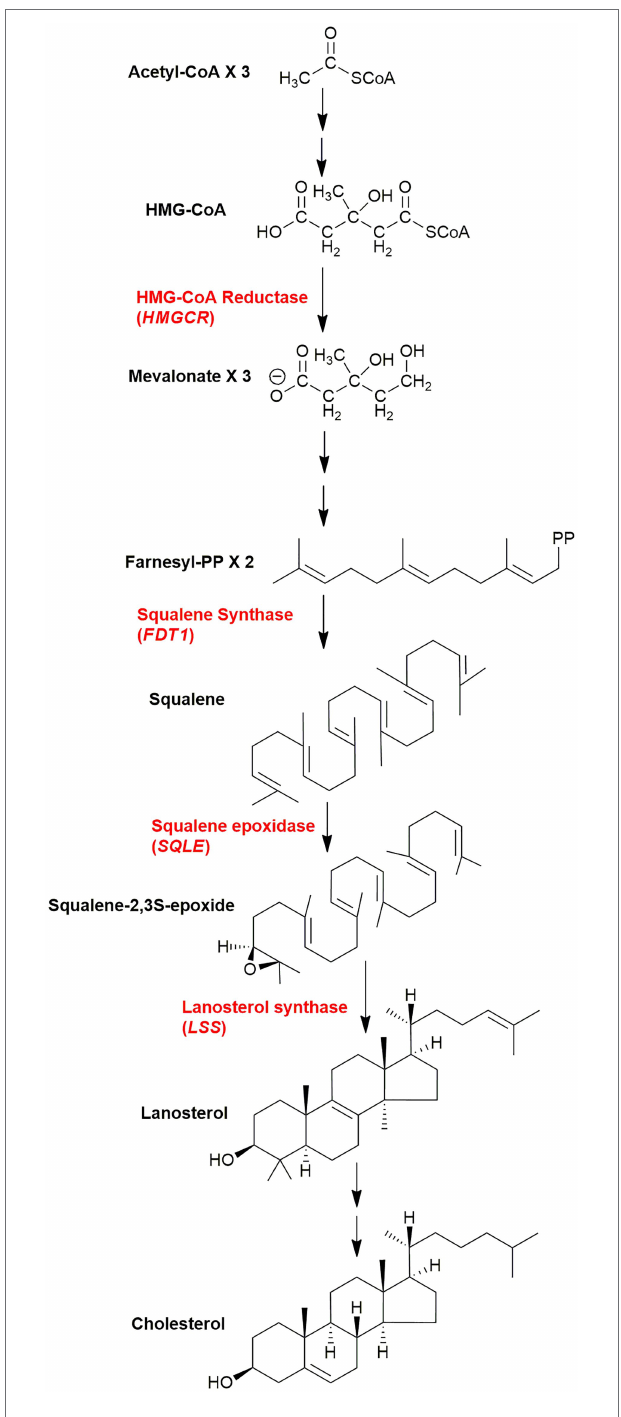
FIGURE 1 | Simplified scheme of the cholesterol biosynthetic pathway. Key enzymes are in red, genes in parenthesis. The pathway post squalene can be found in detail in Figure 6 . The entire pathway including all steps and enzymes can be found in Mazein et al.